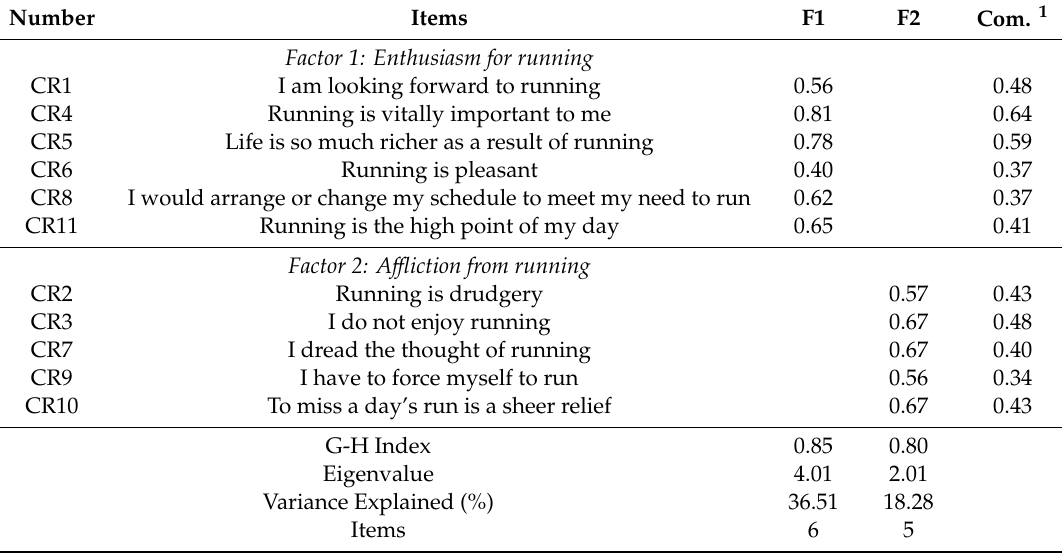
Table 3. Rotated factor structure of the commitment-to-running scale of runners participating in popular endurance races, communalities, eigenvalues, and explained